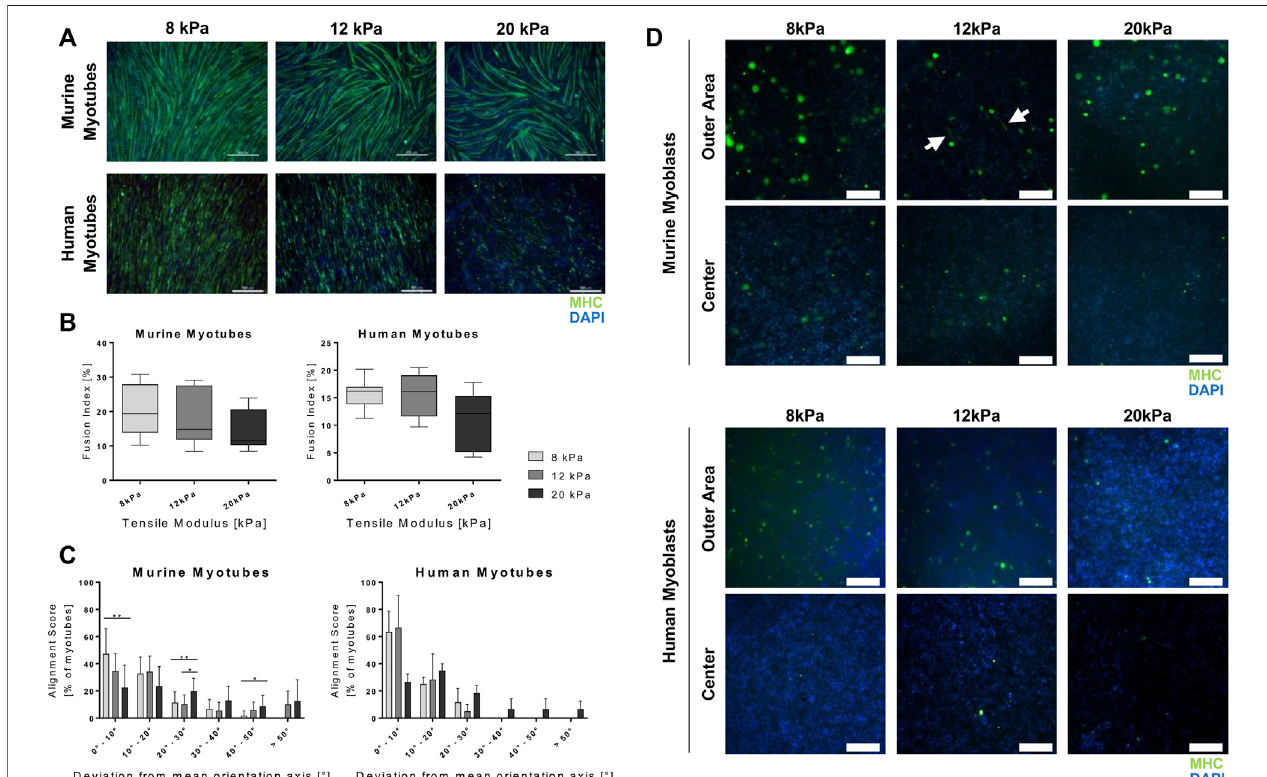
FIGURE 3 | Culture in a 3D environment slows down progression of myogenesis in myoblast cell lines. Murine and human myoblasts were differentiated on fi brin- coatedcellcultureplates(2D)orencapsulatedin fi brinhydrogels(3D)withdifferentstiffness(apparenttensilemodulusof8,12and20 kPa)for5 days.Theywereseeded in growth medium that was replaced by differentiation medium on D1. mRNA expression of marker genes speci fi c for early, mid and late stage myogenesis [ Myf5 (A) , MyoD (B) and myogenin ( MyoG ) (C) , respectively] and cell cycle progression [ cyclin D 1 ( CCND1 ) (D) and p21 (E) ] was assessed by RT-qPCR. Fold change expression levels were normalized to D0 control samples of each cell line and relative expression over time is shown as a linear curve between means of fold-change values (A – D) or normalized tothe 8 kPa group for each condition on day 5 (D5) (E) ; N = 3, n ≥ 8; two-way ANOVA with Sidak ’ s multiple comparison test was performed comparing all rigidities (8, 12 and 20 kPa) of the two (culture set ups (2D vs 3D) with each other (A – D) or one-way ANOVAq with Tukey ’ s multiple comparison test was performed comparing all rigidities for each condition (2D and 3D) with each other (E) , no signi fi cant difference (n.s.), * p < 0.05, ** p < 0.01, *** p < 0.001, **** p <